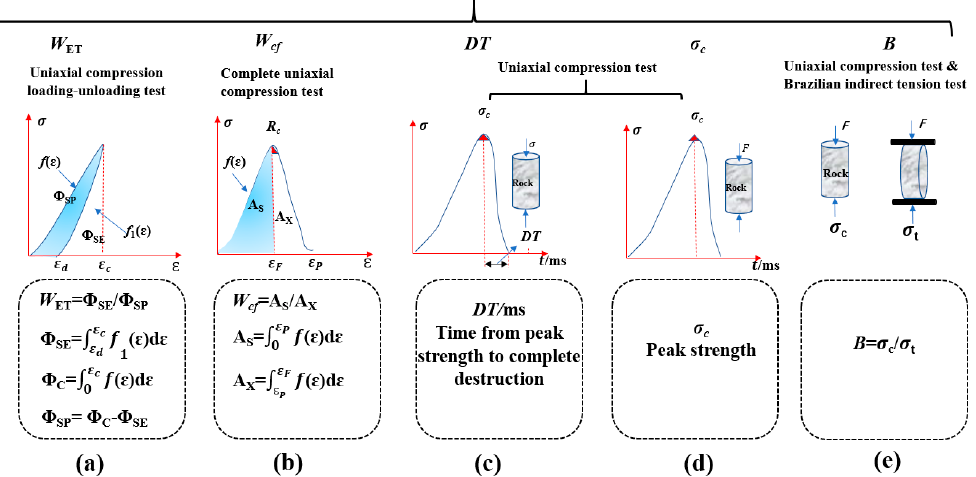
Figure 6. Calculation methods of bursting liability indices. Notes: Φ SE is the elastic strain energy, and it is the area under the unloading curve; Φ C is the total strain energy, and it is the area under the loading curve; Φ SP is the plastic strain energy, and it is the area enclosed by the loading curve and the unloading curve; ε c is the total stain in loading-unloading curve; ε d is the permanent non-elastic strain; ε P is the total stain in comprehensive loading curve; ε F is the stain before pre-peak strength in comprehensive loading curve; A S is the accumulated deformation energy; A X is the dissipate deformation energy; σ c is the uniaxial compressive strength; σ t is the uniaxial tensile strength.